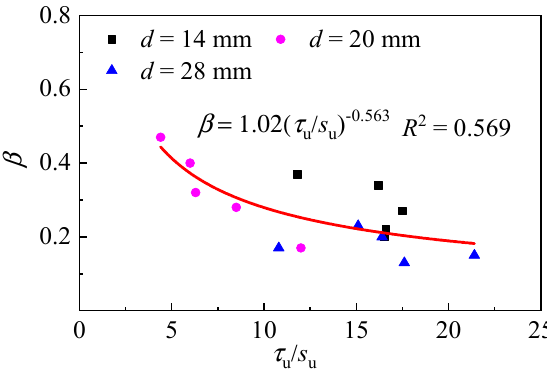
Figure 15. Change of shape coefficient β with τ u / s u .